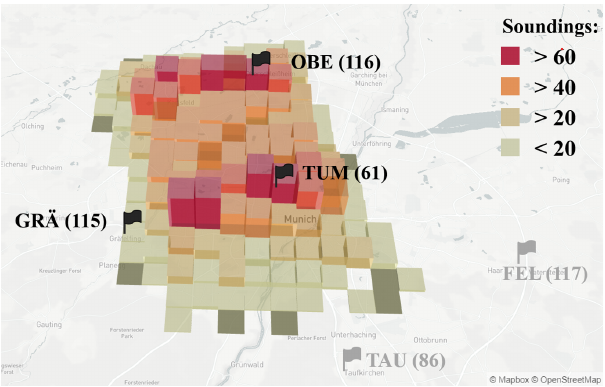
Figure 4. Histogram of the OCO-2 target sounding distribution in Munich. There are three MUCCnet sites with sufficient collocated data, which will be considered in this study. Ground-based instru- ments in Feldkirchen (FEL) and Taufkirchen (TAU) are not featured in this study.